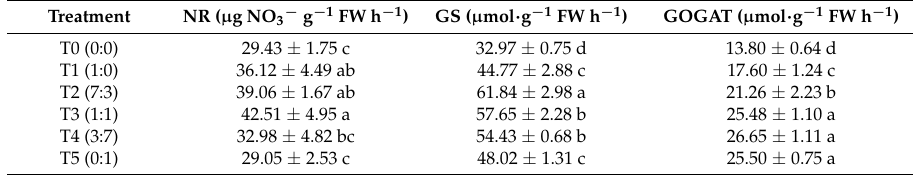
Table 5. Nitrate Reductase (NR), Glutamine Synthetase (GS), and Glutamate Synthase (GOGAT) activities in leaves of Camellia oleifera ‘Xianglin 27’ seedlings fertigated with six nutrient solutions varying in NO 3 − to NH 4+